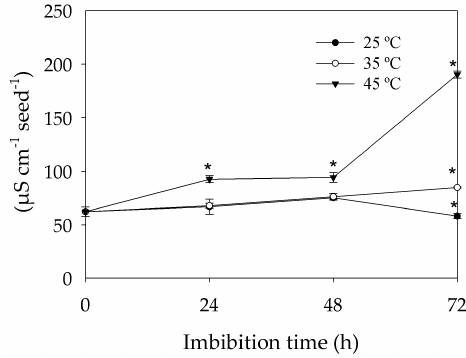
Figure 2. Electric conductivity in Melanoxylon brauna seeds under different temperatures and soaking periods. * Indicates statistical difference between means. Vertical bars = ± SE, n =